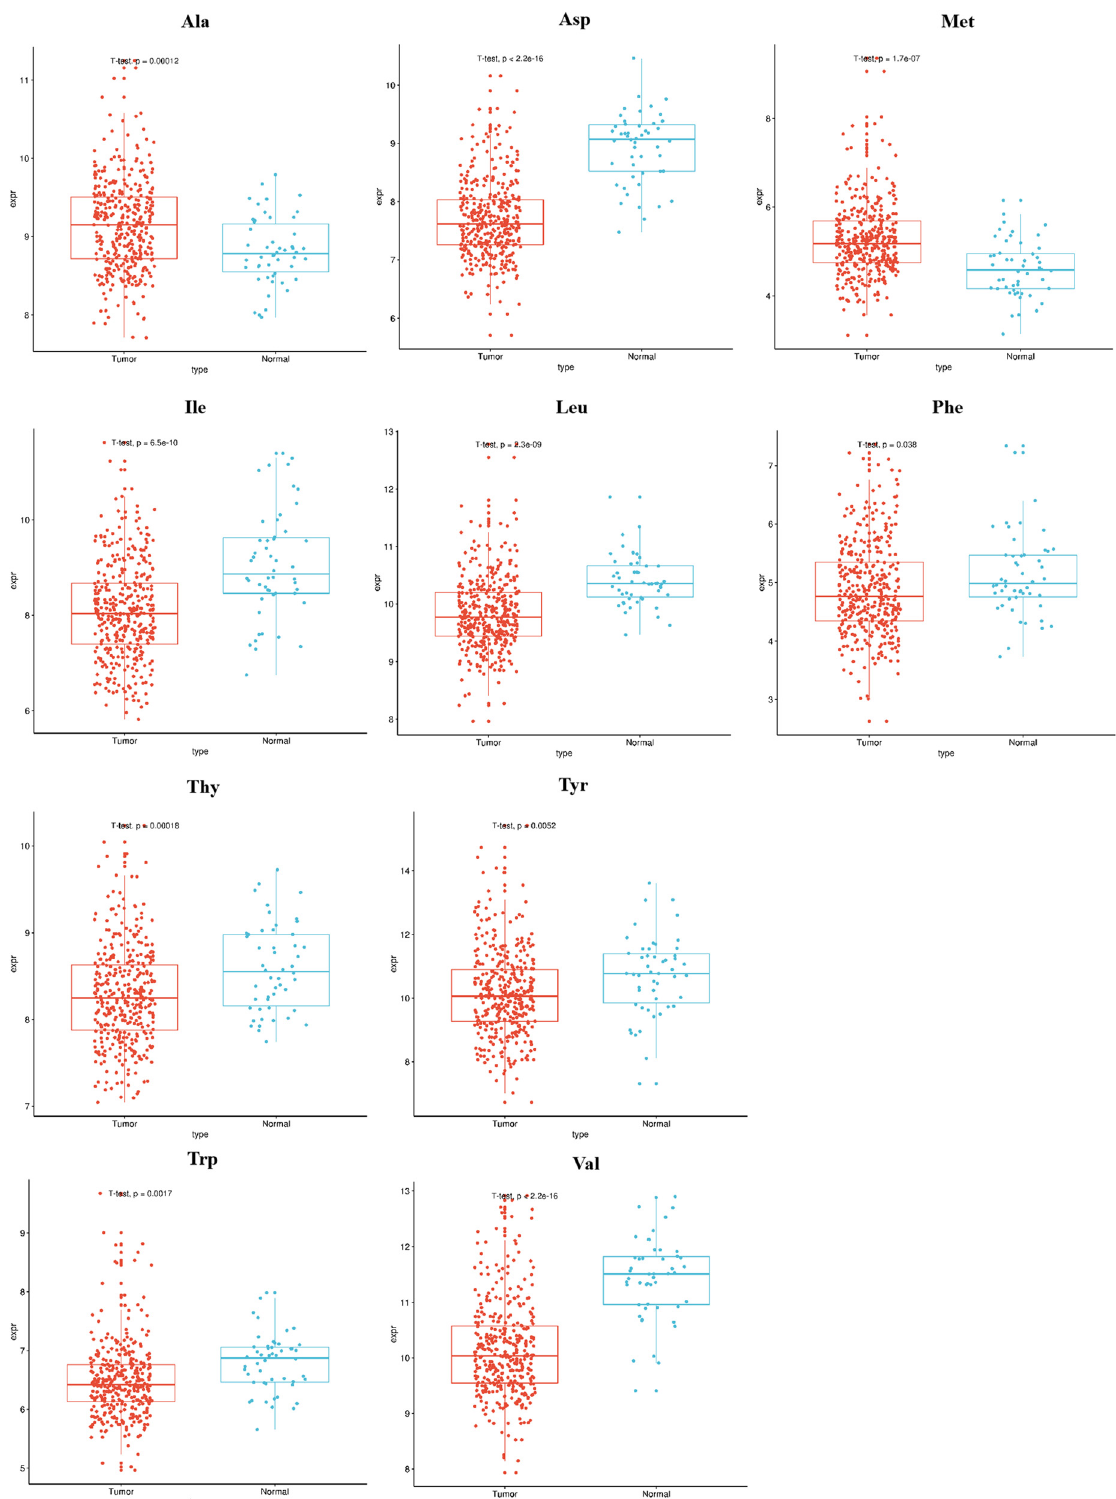
Figure 1: AA levels in tumor tissues and matched normal tissues of patients with liver